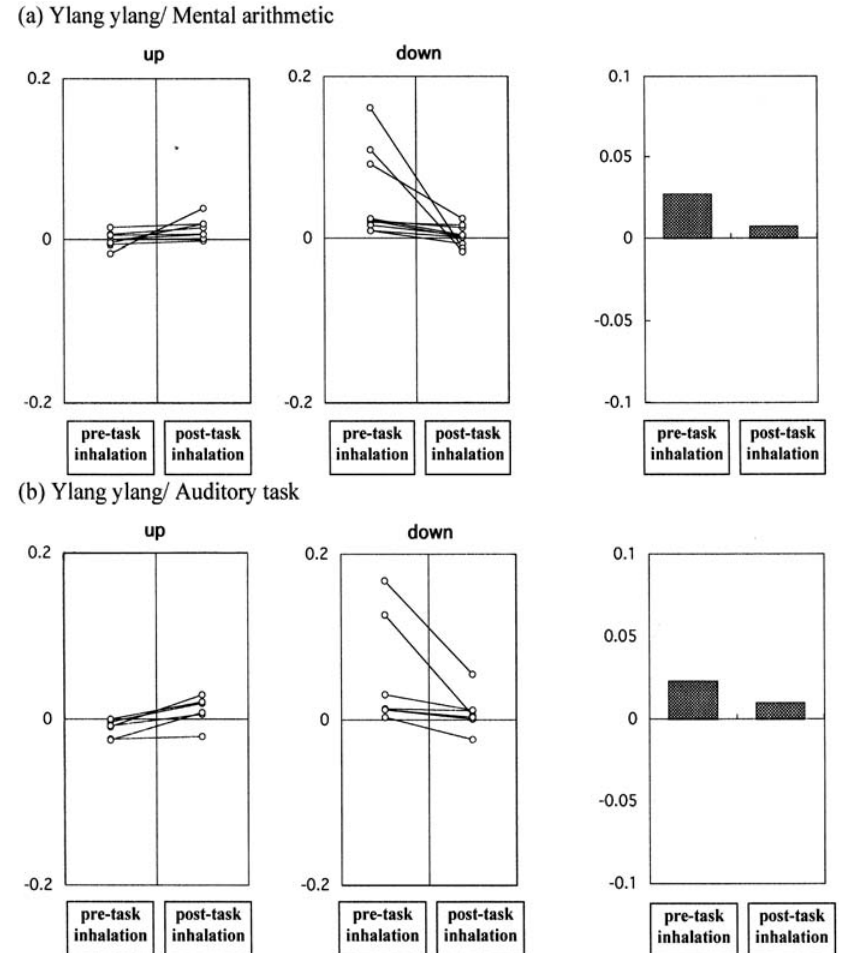
Figure 8. Skin temperature changes following inhalation of ylang ylang as a function of behavioural task. The circumstances are identical to those shown in Figure 5. ( a ) The number of subjects was 18 as for ylang ylang/mental arithmetic; and ( b ) was 20 as with ylang ylang/auditory